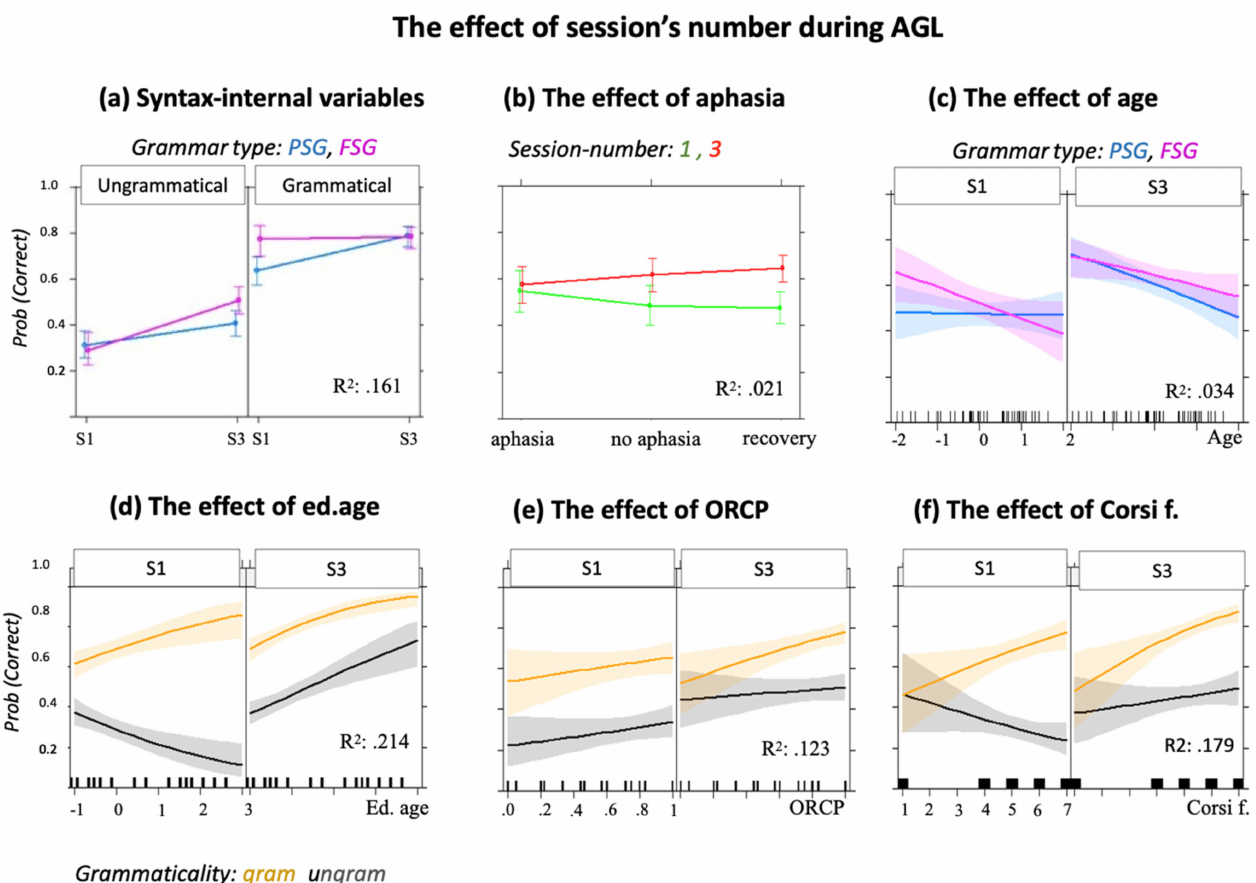
(Table 4A): accuracy on PSG trials was worse than that on FSG trials, but only for grammatical trials in pre-training sessions and for ungrammatical trials in post-training sessions.